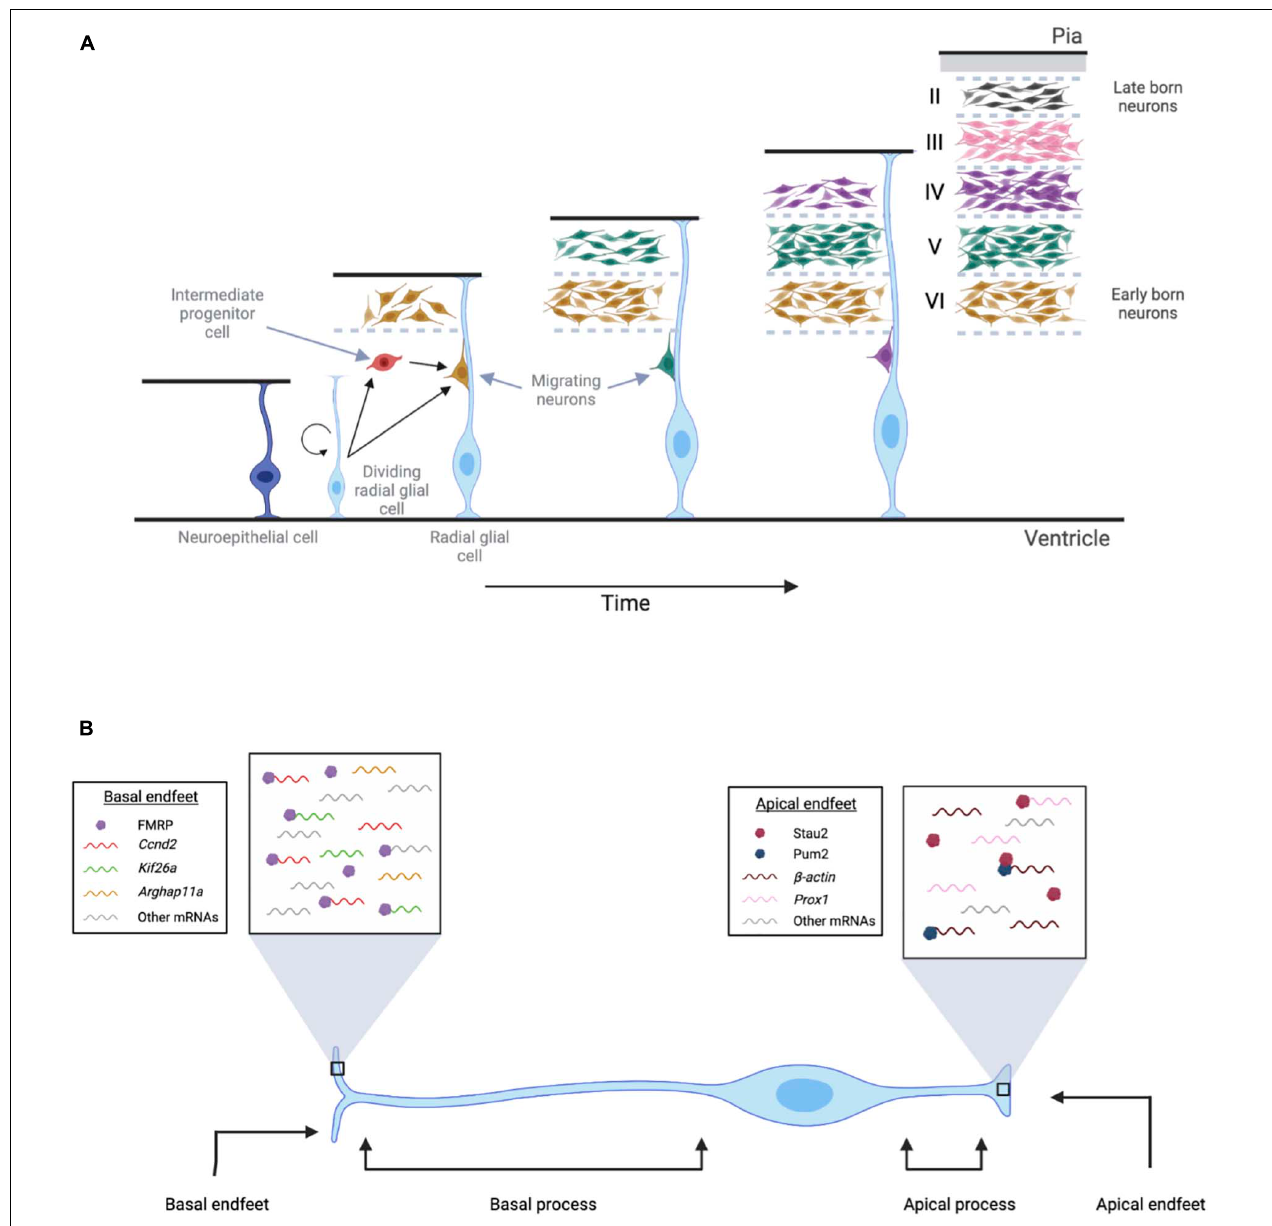
FIGURE 1 | Localization of mRNAs and RBPs in radial glial cells during neurogenesis. (A) Neuroepithelial cells (dark blue) undergo symmetric division before neurogenesis begins and give rise to a pool of neural progenitor cells. During neurogenesis, these neuroepithelial cells transition into radial glial cells (light blue), which have a longer process extending toward the pial region and a shorter process extending toward the ventricular surface. As development progresses, radial glial cells can divide either symmetrically or asymmetrically to form more radial glial cells, intermediate progenitor cells (red), and neurons. Using radial glial cells as a scaffold, newly born neurons migrate toward the pial surface, forming cortical layers II-VI. (B) FMRP, Stau2, and Pum2 localize mRNAs to radial glial cell endfeet. In the basal endfeet, local translation of Ccnd2 and Kif26a mRNA likely regulates cell fate and microtubule dynamics. Arhgap11a mRNA also localizes in the basal endfeet, and its local translation contributes to the laminar organization of the developing cortex. In the apical endfeet, the local translation of β -actin and prox1 mRNAs contribute to cell fate determination and cytoskeletal remodeling.